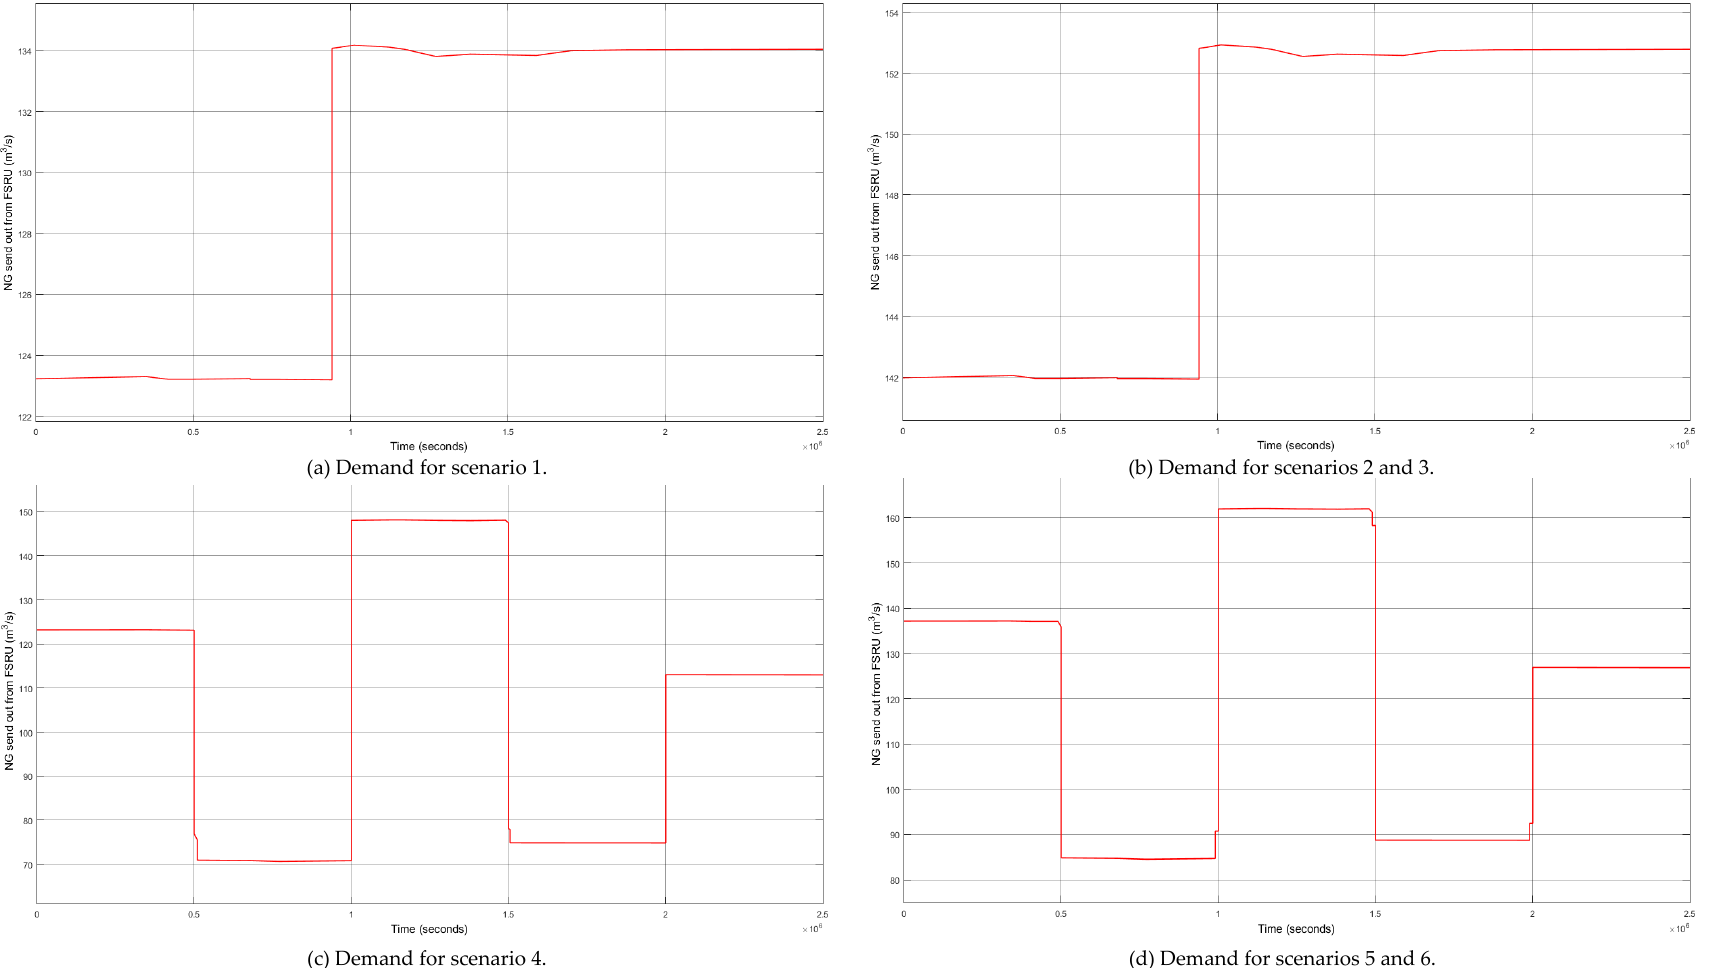
Figure 6. Natural gas demand for di ff erent operation scenarios presented in the form of send out rate from the